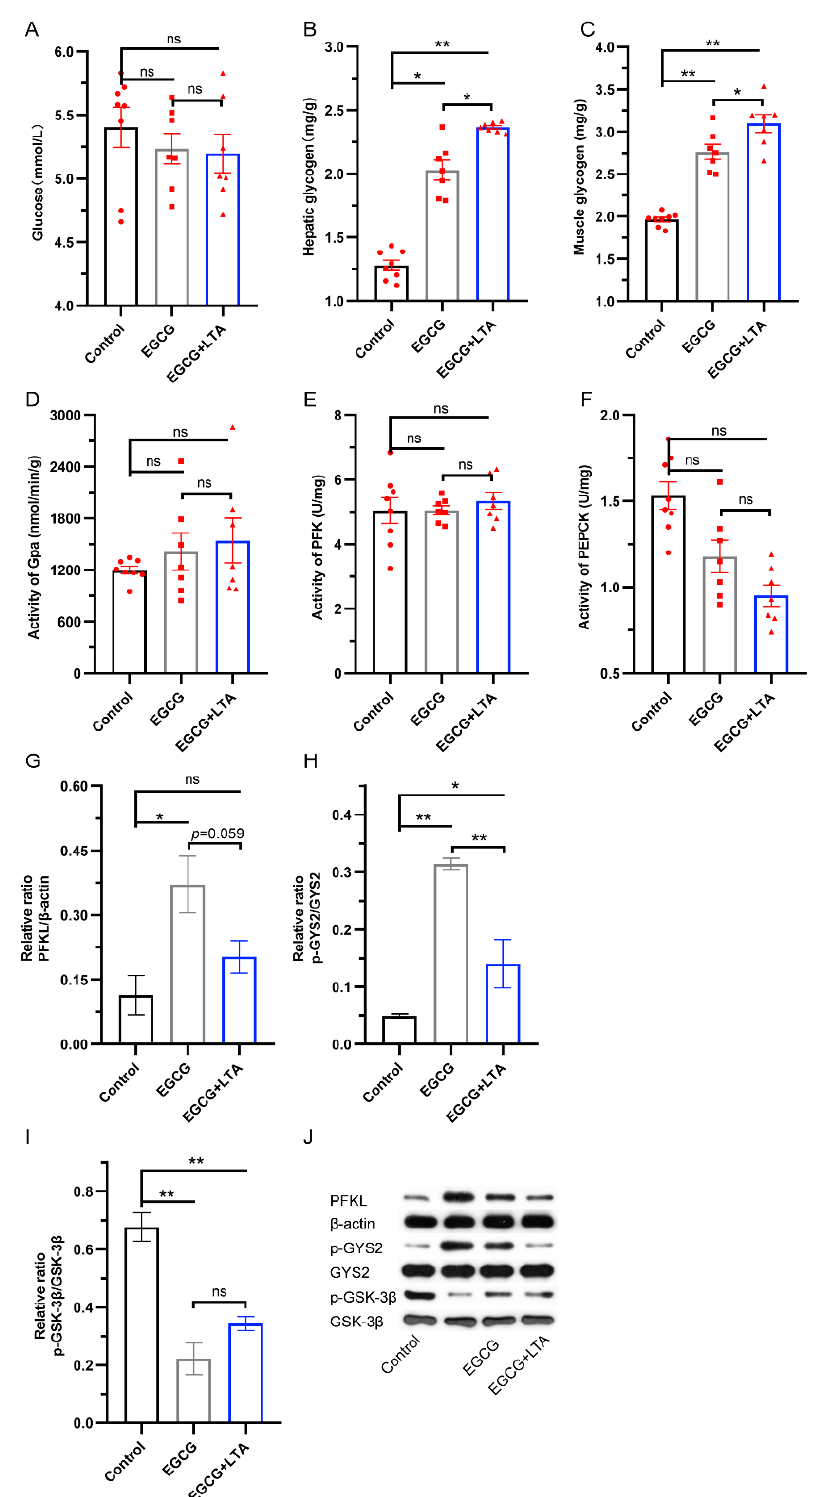
Figure 2. LTA cooperated with EGCG to promote glycogen synthesis. Blood glucose ( A ), hepatic glycogen ( B ), and muscle glycogen ( C ) contents in different groups. Activities of liver GPa ( D ), PFK ( E ), and PEPCK ( F ) among the three groups. Relative protein expression of PFKL ( G ) and phosphorylation level of GYS2 ( H ) and GSK-3 β ( I ) in rat livers ( J ). Values are expressed as the mean ± SE. * p < 0.05 and ** p < 0.01. ns: no significant difference.